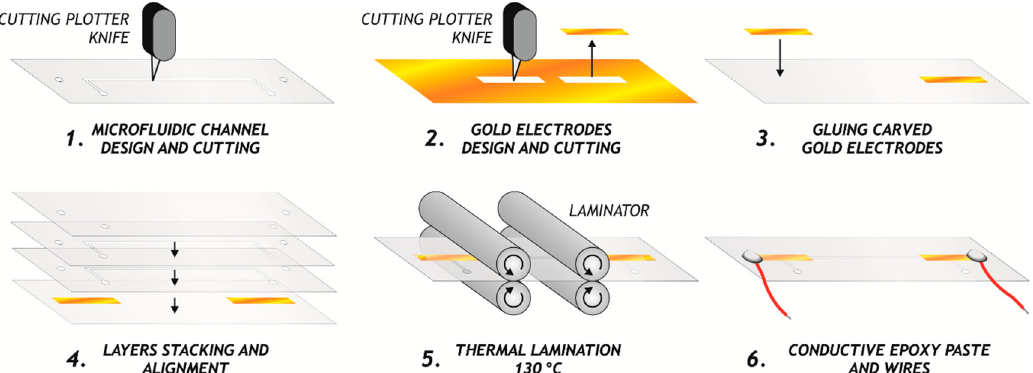
Figure 1. The main fabrication steps in fabrication of a microfluidic component by means of xurography technique: microfluidic channel cutting in PVC foil, electrodes cutting in gold layer, layers stacking and alignment, as well as their lamination .